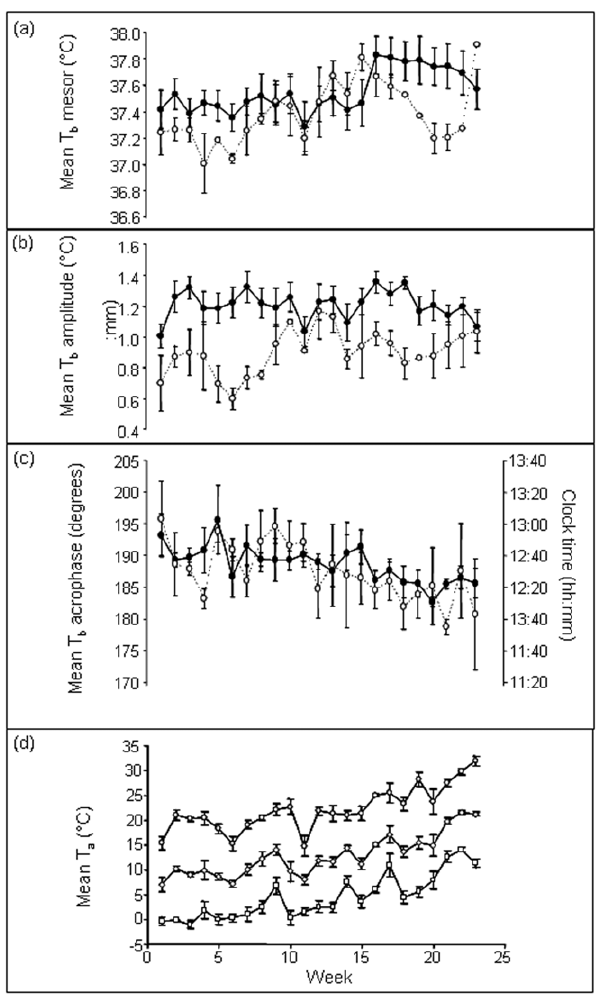
Figure 2. Mean ± SE daily rhythm parameters of eight Cape ground squirrels during the 23 week measurement period for: (a) T b Mesor ( 6 C); (b) T b Amplitude ( 6 C); (c) T b Acrophase (time of day and degrees). Individuals inhabiting the flood plain and the woodland are denoted by solid and open circles. Maximum, minimum and mean T a values are shown in ( d ) as top, middle and lower lines.